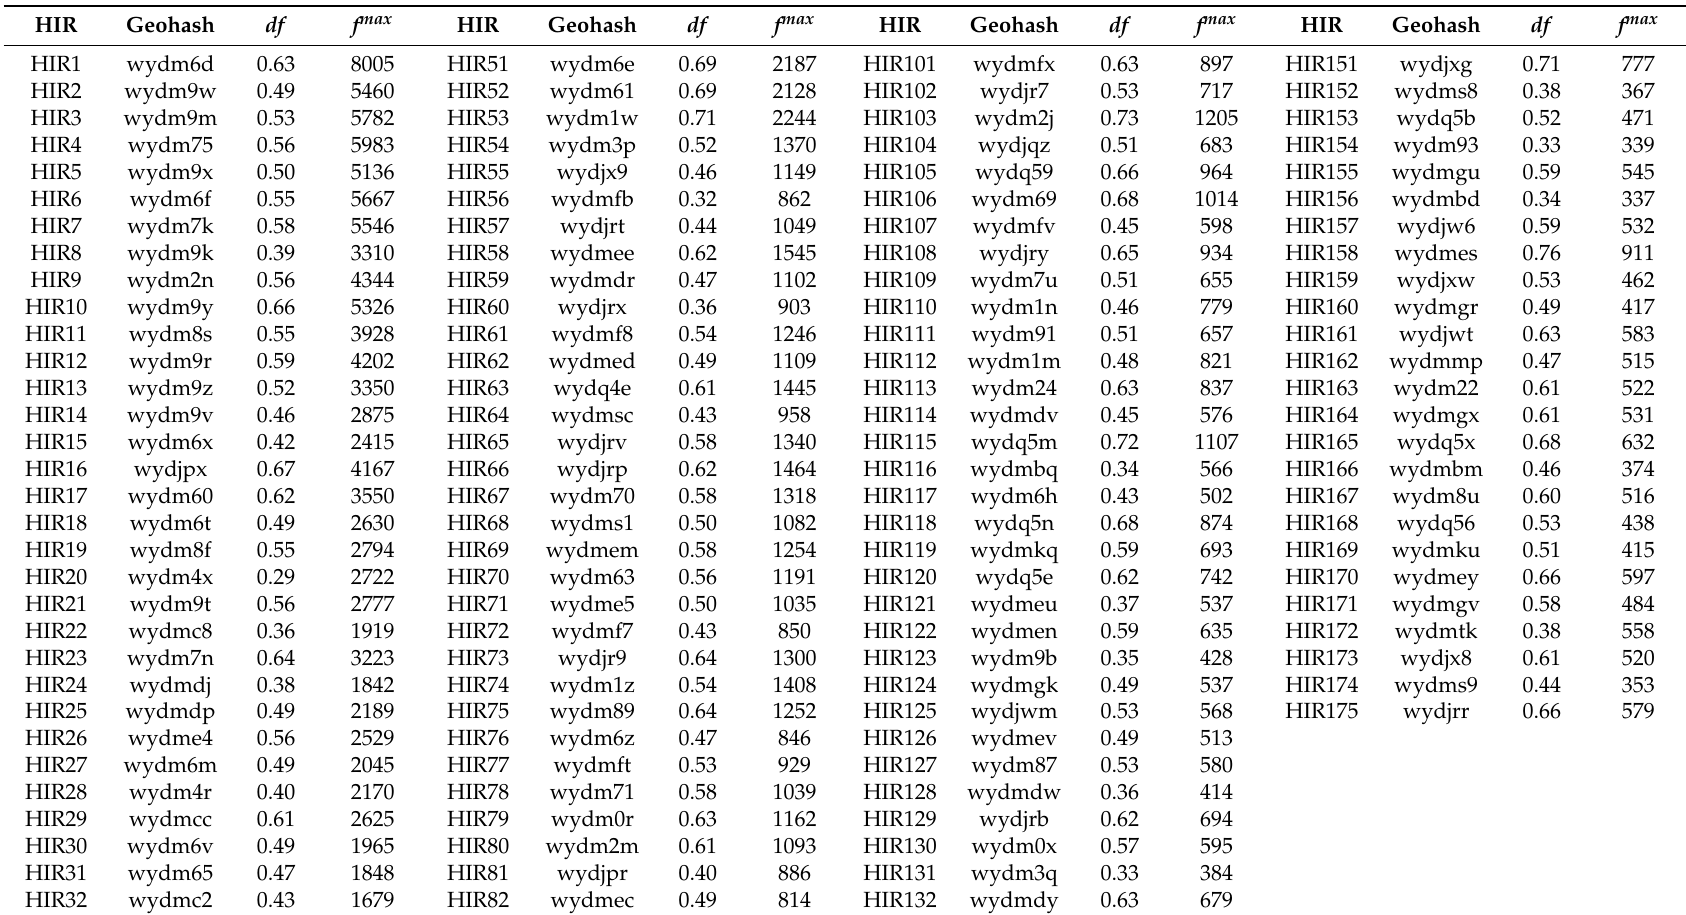
Table A1. Description of HIRs in